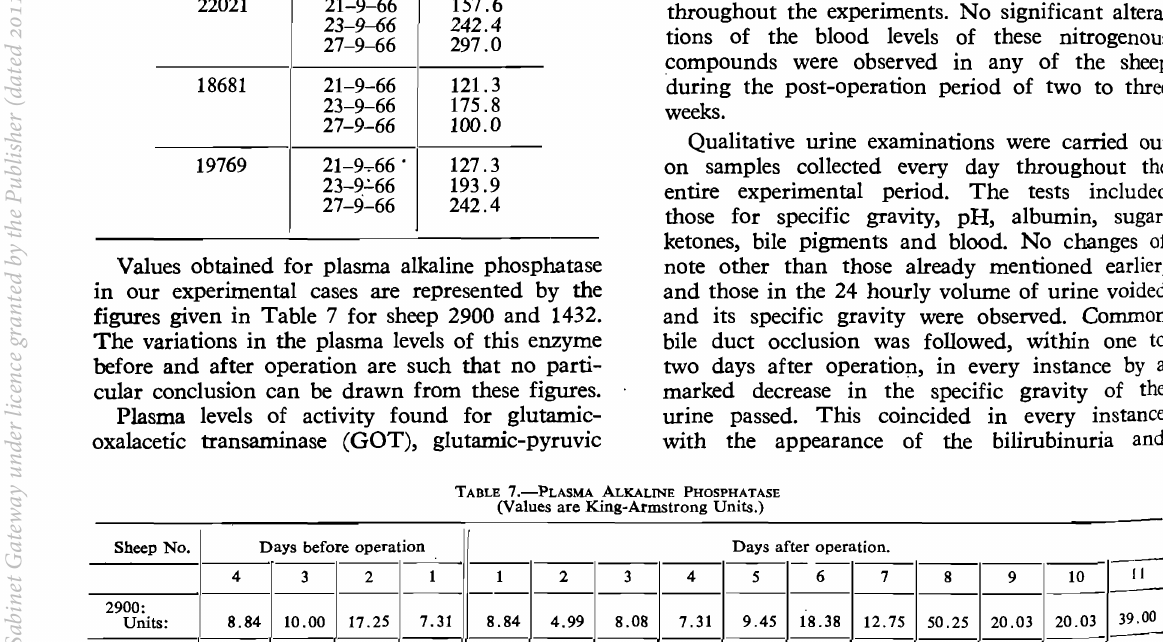
TABLE 7.-PLASMA ALKALINE PHOSPHATASE (Values are King-Armstrong Units.) Sheep No. Days before operation Days after